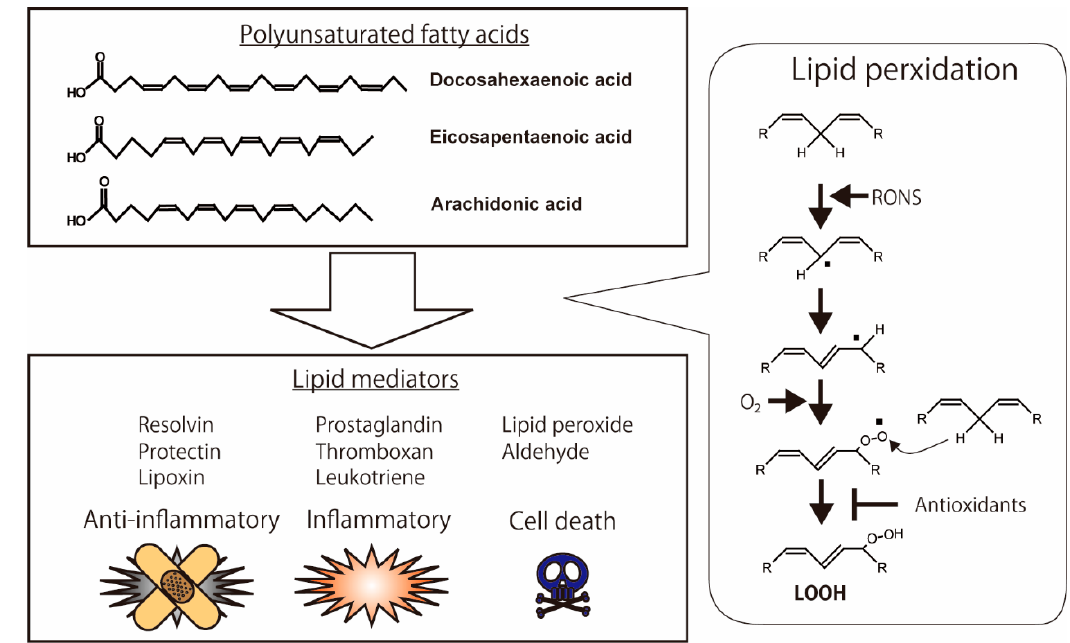
Figure 1. Oxidation of polyunsaturated fatty acids (PUFAs) and production of lipid mediators. Anti-inflammatory lipid mediators, such as resolvin, protectin, and lipoxin, are produced from PUFAs. Pro-inflammatory lipid mediators, such as prostaglandin, thromboxane, and leukotriene, are also metabolized from PUFAs. The highly reactive chemicals, including hydroperoxide and aldehyde, have the binding activities of biomolecules in the cells, which lead to cell death. The illustration was adapted from Iuchi (2021).